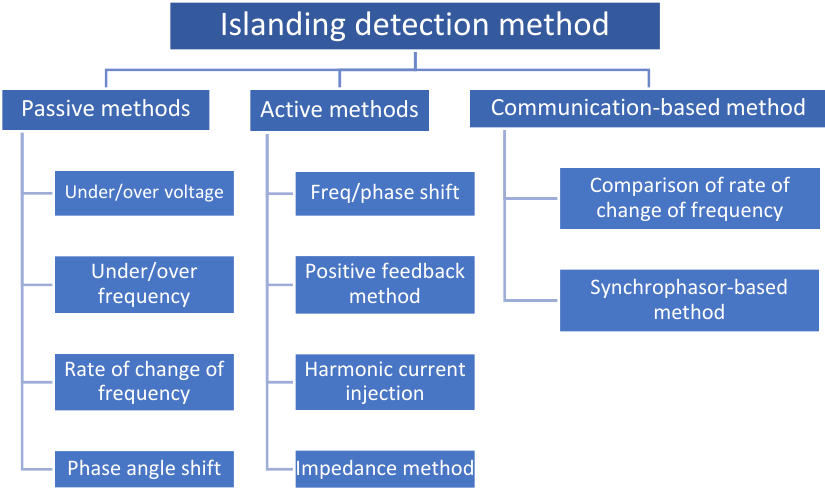
Figure 1. Islanding detection solutions classification.